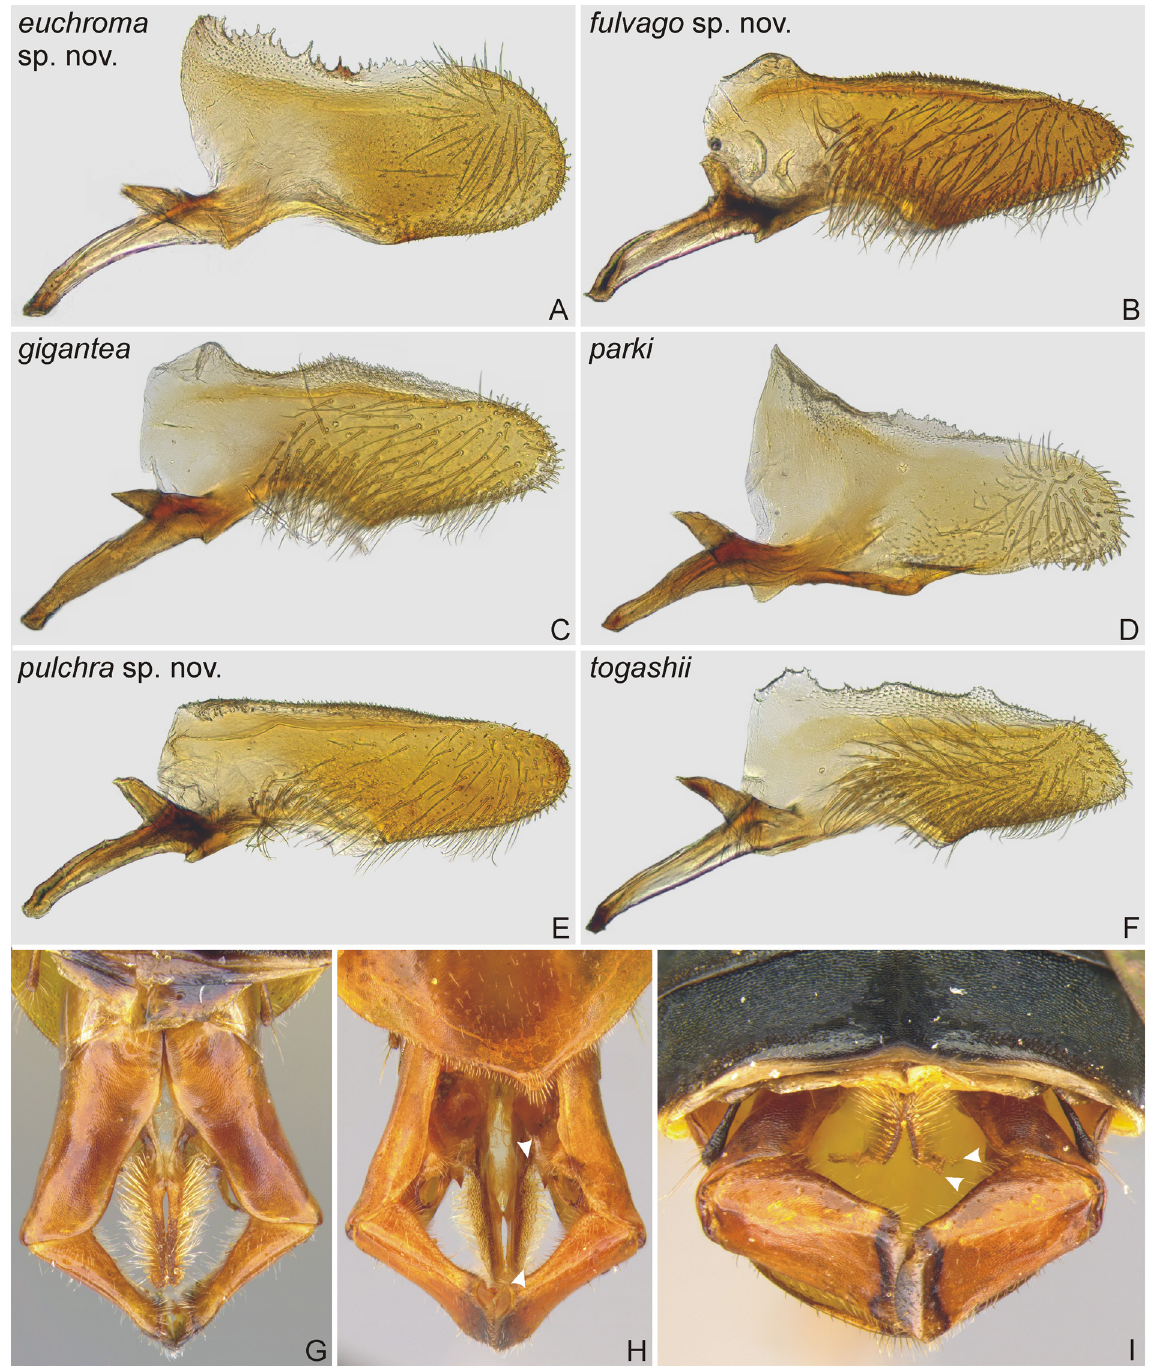
Fig. 13. Species of Megaxyela Ashmead, 1898, penis valves (A–F) and genitalia capsules (G–I). A . M. euchroma Blank, Shinohara & Wei sp. nov. (DEI-GISHym 22513, NSMT). B . M. fulvago Blank, Shinohara & Wei sp. nov. (5239, NSMT). C . M. gigantea Mocsáry, 1909 (708, NSMT). D . M. parki Shinohara, 1992 (710, NSMT). E . M. pulchra Blank, Shinohara & Sundukov sp. nov. (18503, NSMT). F . M. togashii Shinohara, 1992 (22521, NSMT). G–H . M. gigantea , genitalia capsule in dorsal/ventral view (18507, NSMT). I . M. pulchra sp. nov., genitalia capsule in dorso-posterior view (22349, NSMT). Arrow heads in Fig. 13H–I indicate lobe of upper side of valviceps coiled laterally. Images not to same